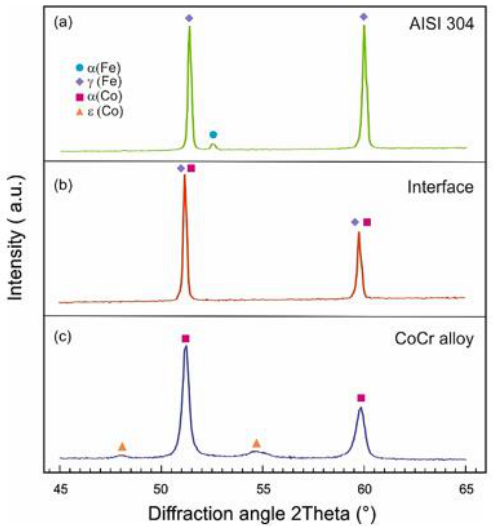
Figure 15. XRD patterns measured on specimen: ( a ) AISI 304 steel; ( b ) interface; ( c ) CoCr alloy.